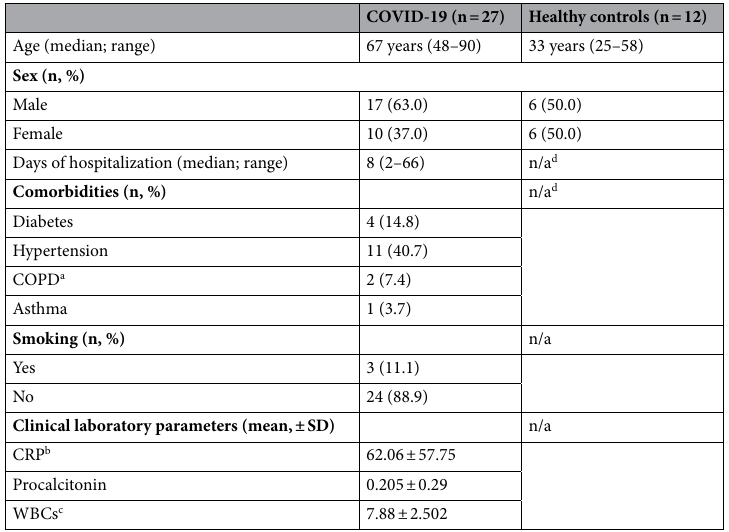
Table 1. Summary of the clinical and demographic characteristics of enrolled patients and healthy controls. a Chronic obstructive pulmonary disease. b C-reactive protein. c White blood cell count. d Not applicable.